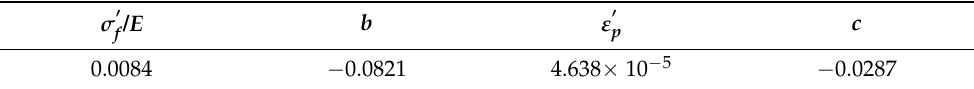
Table 4. Parameter fitting results under 600 ◦ C test